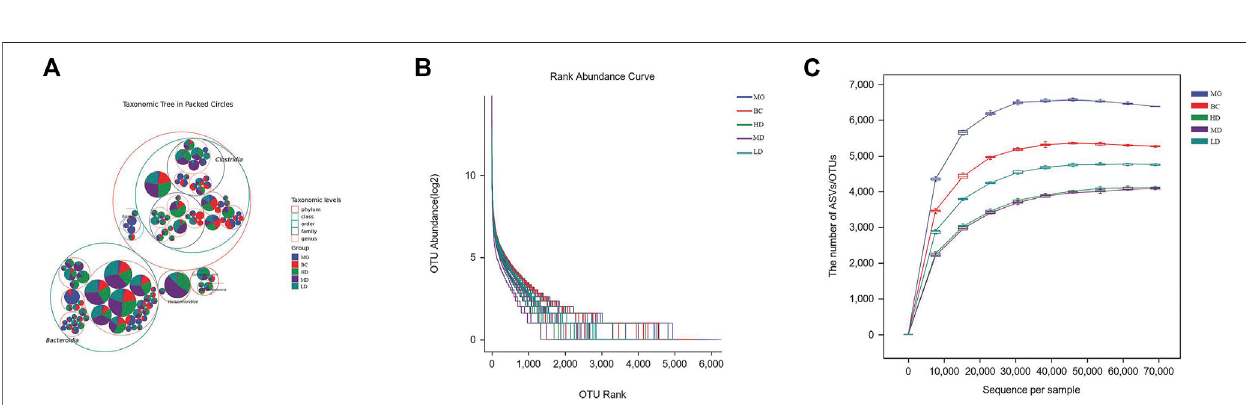
FIGURE 4 | Effect of SEJZ treatment on the intestinal micro fl ora of rats suffering from hyperlipidemia induced by consumption of a HFD. (A) Species composition. (B) Rarefaction curves. (C) Curve showing rank abundance.